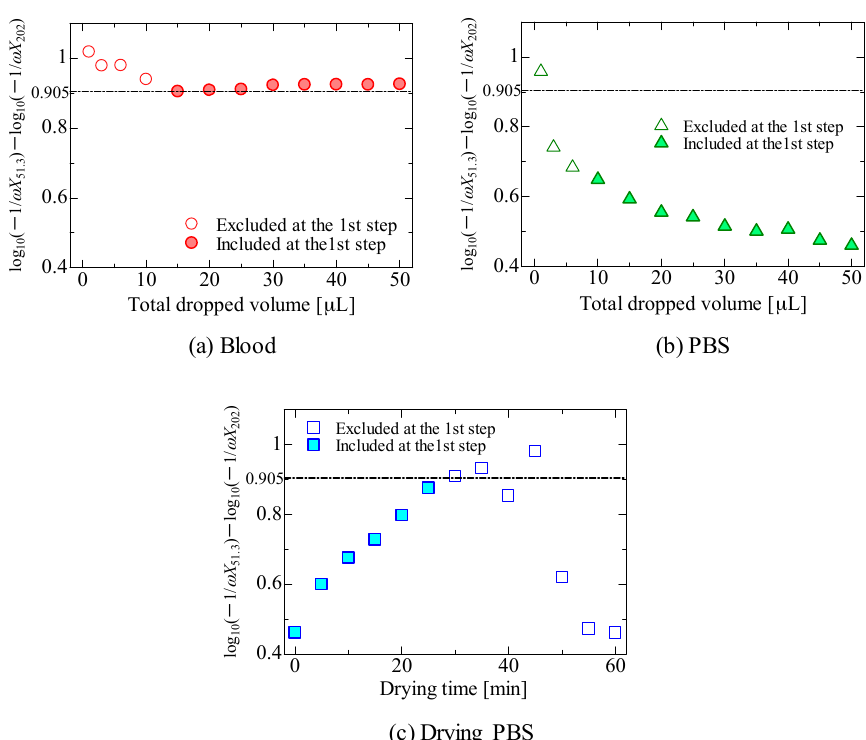
Figure 8. Slope values of log 10 ( − 1/ ω X 51.3 ) − log 10 ( − 1/ ω X 202 ), as a function of the volume obtained when ( a ) blood or ( b ) PBS was dropped to the sensor. The slope value as a function of the sensor’s drying time in which a total volume of 50 µ L of PBS was dropped is shown in ( c ). Excluded and included conditions at the first selection step, estimated from Figure 7, are indicated in each figure. Furthermore, the minimum slope value shown in ( a ) is 0.905, which is indicated in other figures as a visual guide.